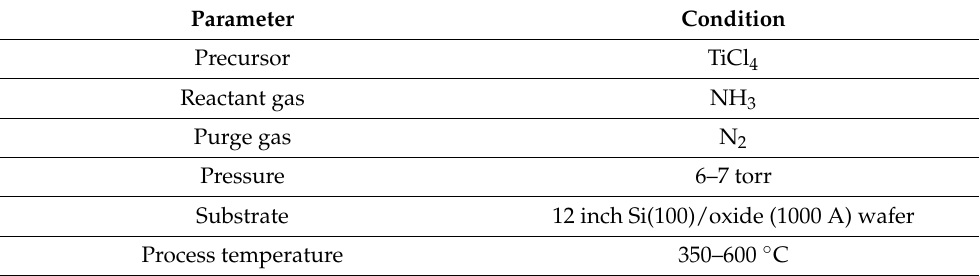
Table 1. Experimental conditions for deposition.